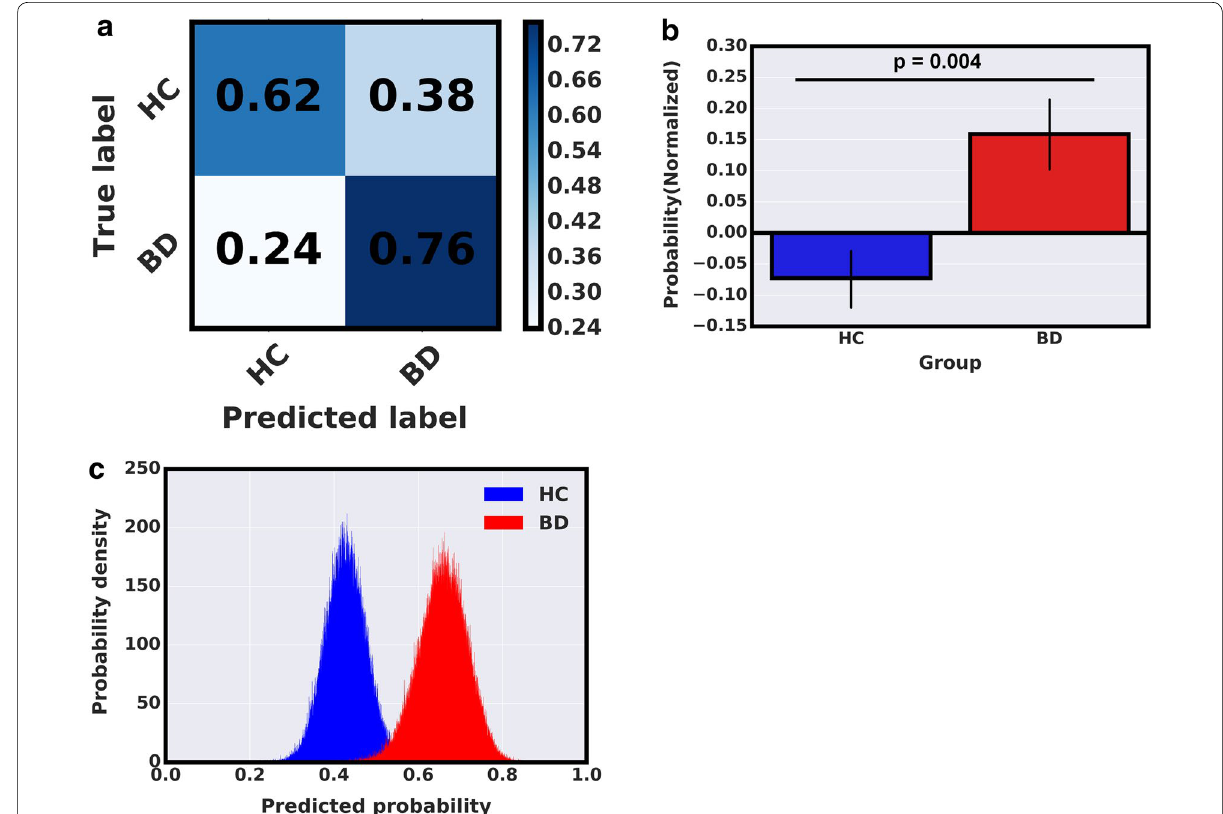
Fig. 2 a A ‘confusion matrix’ depicting actual and LASSO predicted diagnostic labels in the discovery cohort. b A comparison of predicted probabil‑ ity scores between BD patients and HCs in the discovery cohort. c A bootstrapping calculation was performed to estimate distribution of the mean predicted probability for BD patients and HCs in the discovery